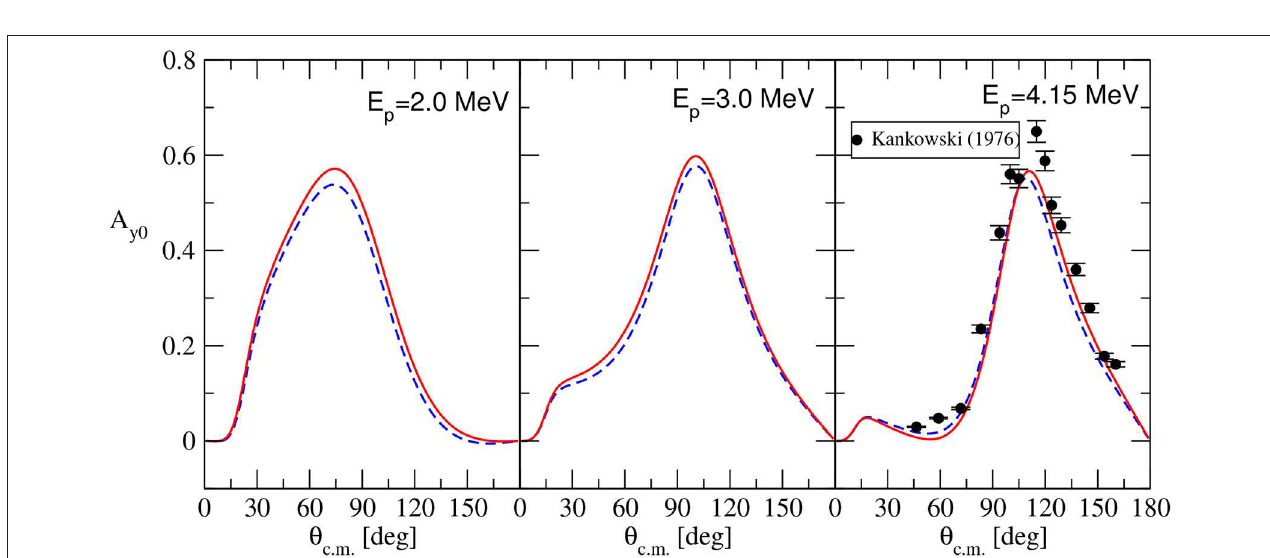
FIGURE 8 | p − 3 H proton analyzing power at three values of the proton laboratory beam energy E p calculated with the N3LO-I (dashed blue lines) and with the N3LO-I/N2LO (solid red lines) interactions. The experimental data are from reference